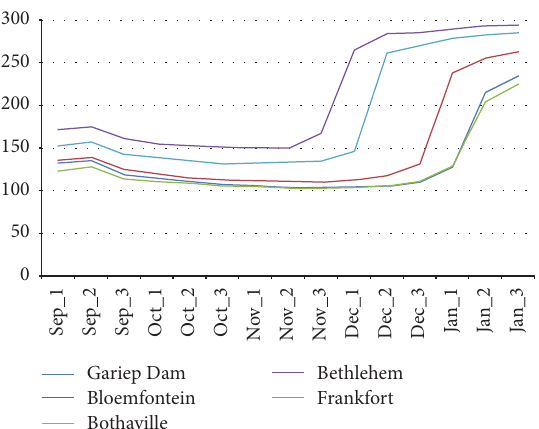
Figure 3: Length of growing period in days for a short season maize variety for the Gariep Dam, Bloemfontein, Bothaville, Bethlehem, and Frankfort stations from the 1st dekad of September to 3rd dekad of January.